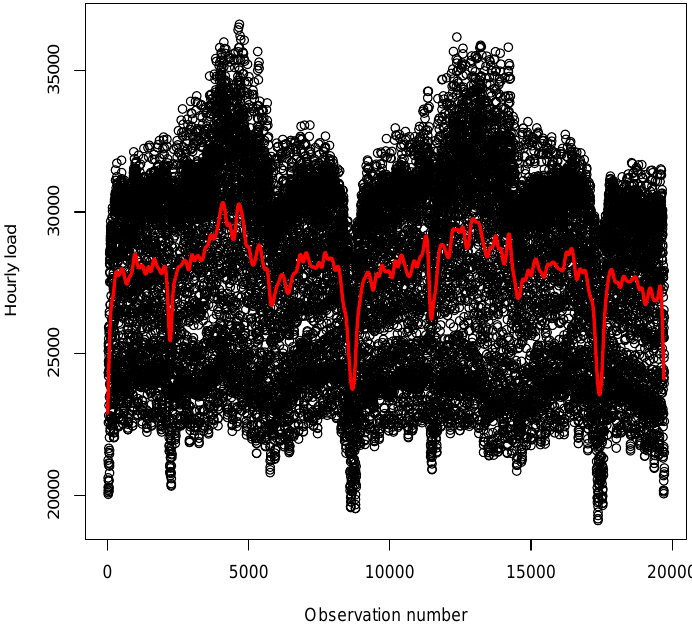
Figure 2. Plot of hourly electricity demand from 1 January 2010 to 31 December 2012 superimposed with a nonlinear